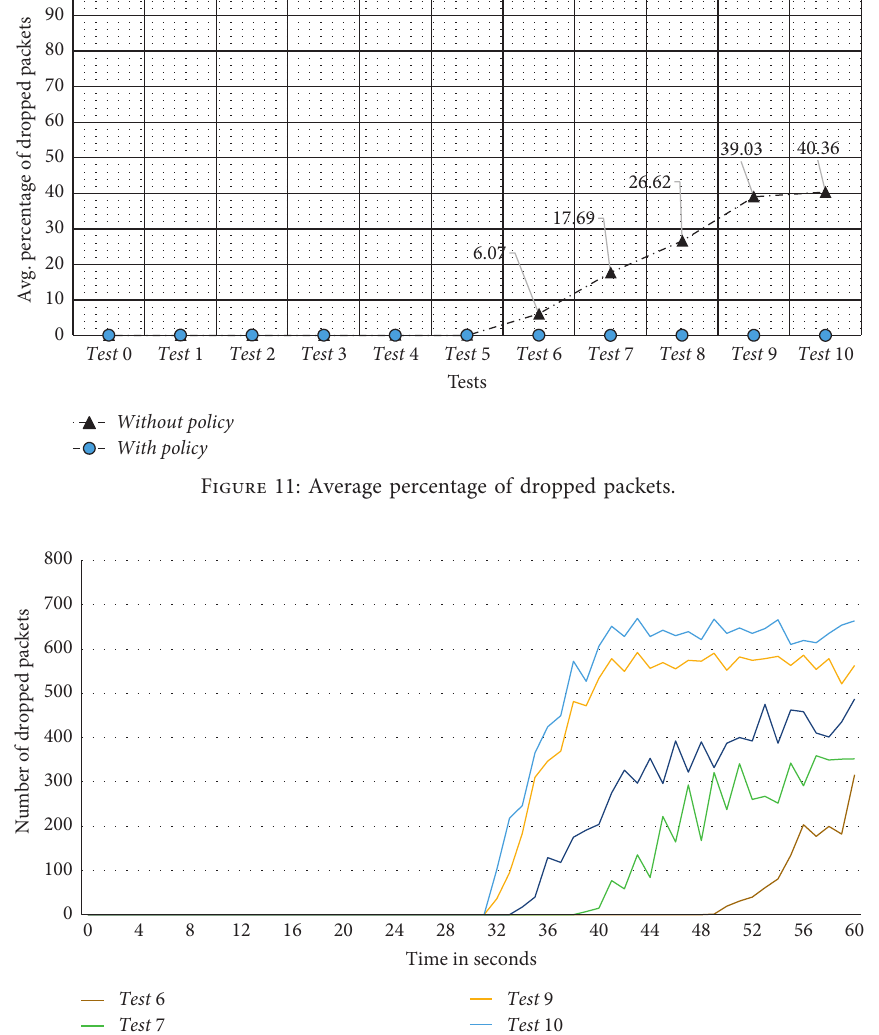
Figure 12: Number of dropped packets by the kernel without